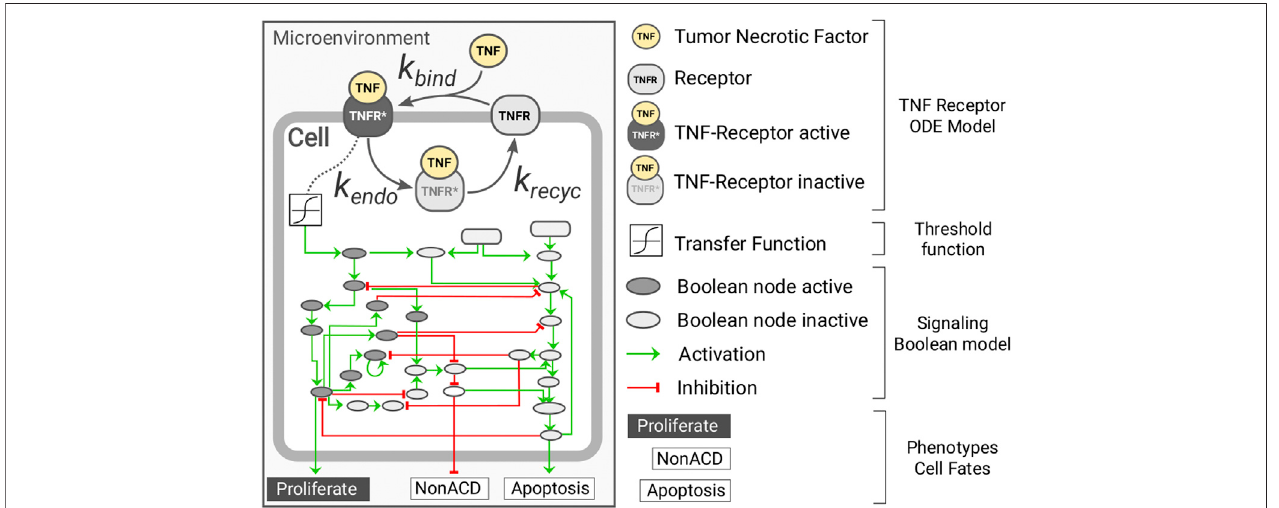
FIGURE 1 | Diagram representing the intracellular submodels of the multi-scale model of tumor growth. Each individual cell agent has a kinetic model of the TNF receptor dynamics connected to the microenvironment through the presence of surrounding TNF and coupled to the Boolean network through a transfer function. The Boolean network has three readout nodes (proliferation, NonACD, and apoptosis), which rule the fate of the cell